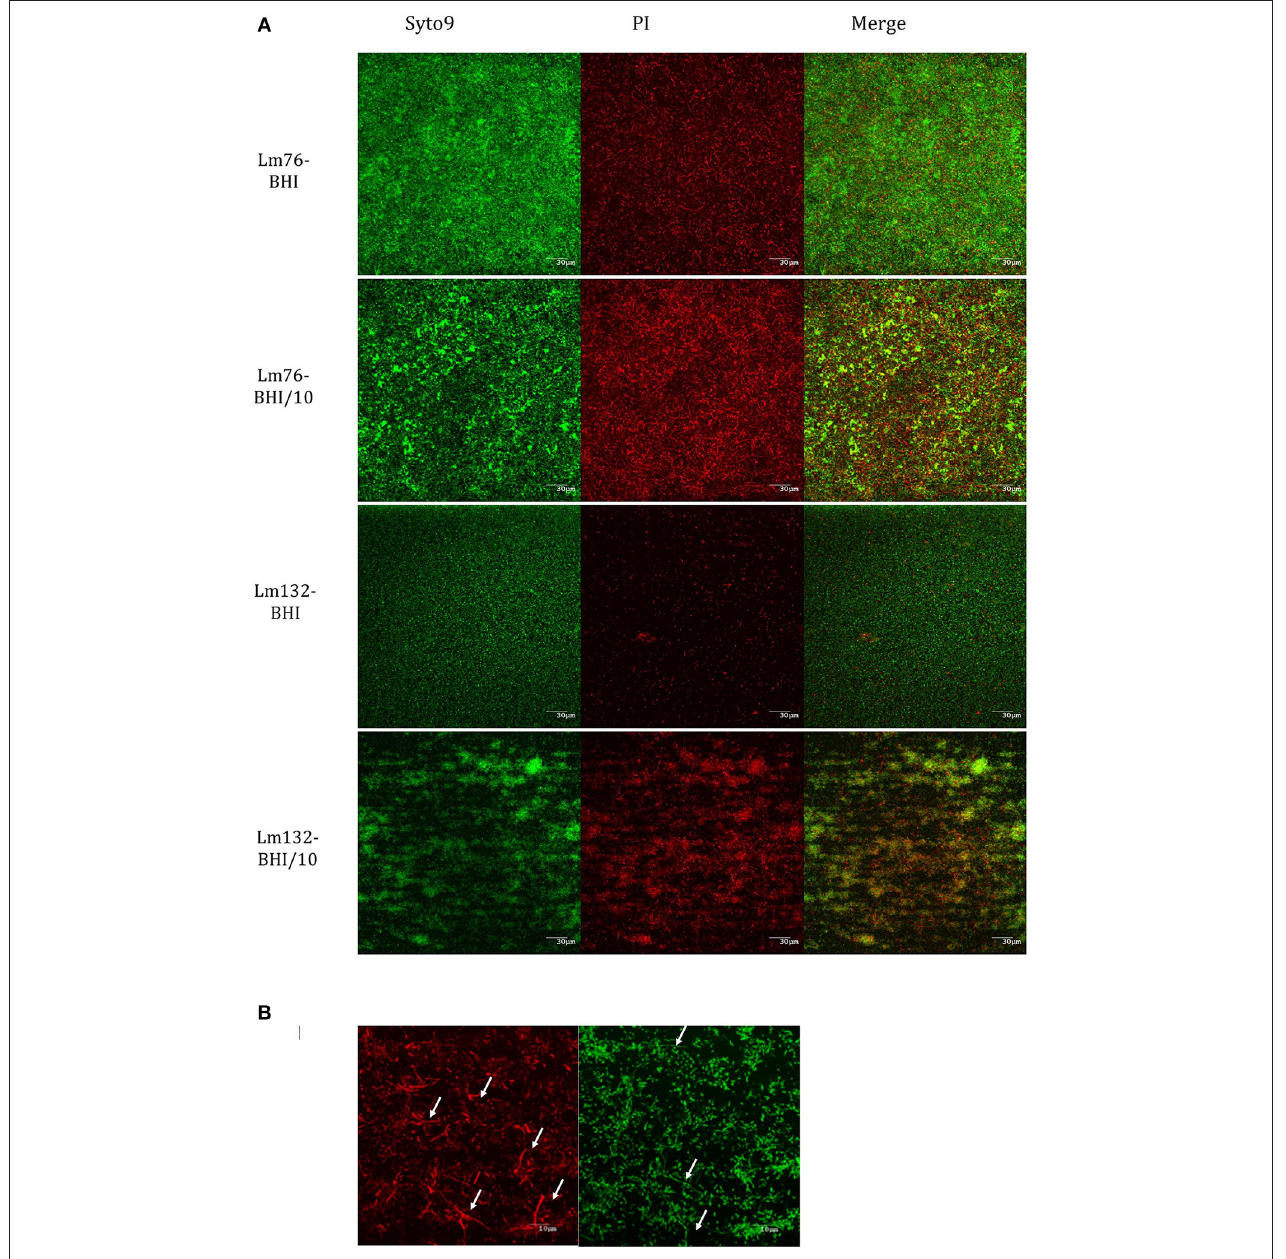
FIGURE 2 | Composition of dead and live cells in the biofilm of Lm76 and Lm132 strains of L. monocytogenes formed in rich medium BHI and diluted medium BHI/10 for 24 h; (A) individual visualization of live population of the biofilm (left images), dead population (middle image) and the merge of the two images which represents the compilation of all images taken from the top of the biofilm to the bottom and corresponds to the total biomass formed in the biofilm (right image). (B) higher magnification (taken with a 100X objective) of Lm76 biofilm grown in the diluted medium BHI/10 showing dead (right image) and live (left image) biomass organization; arrows show filaments mostly present in dead biomass in the